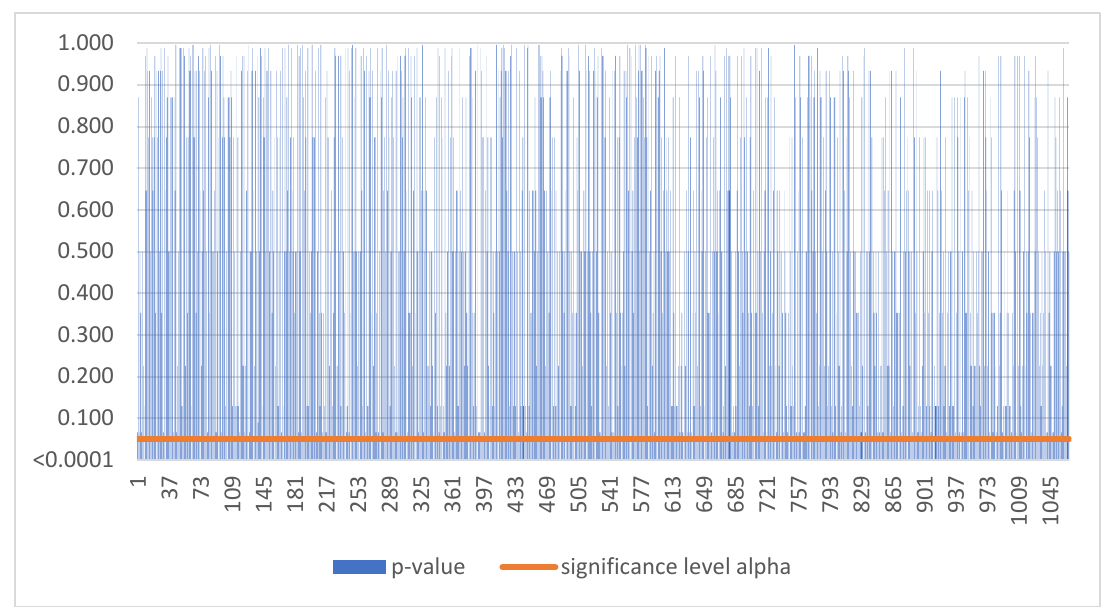
Figure 2. No trend in Slovakia.